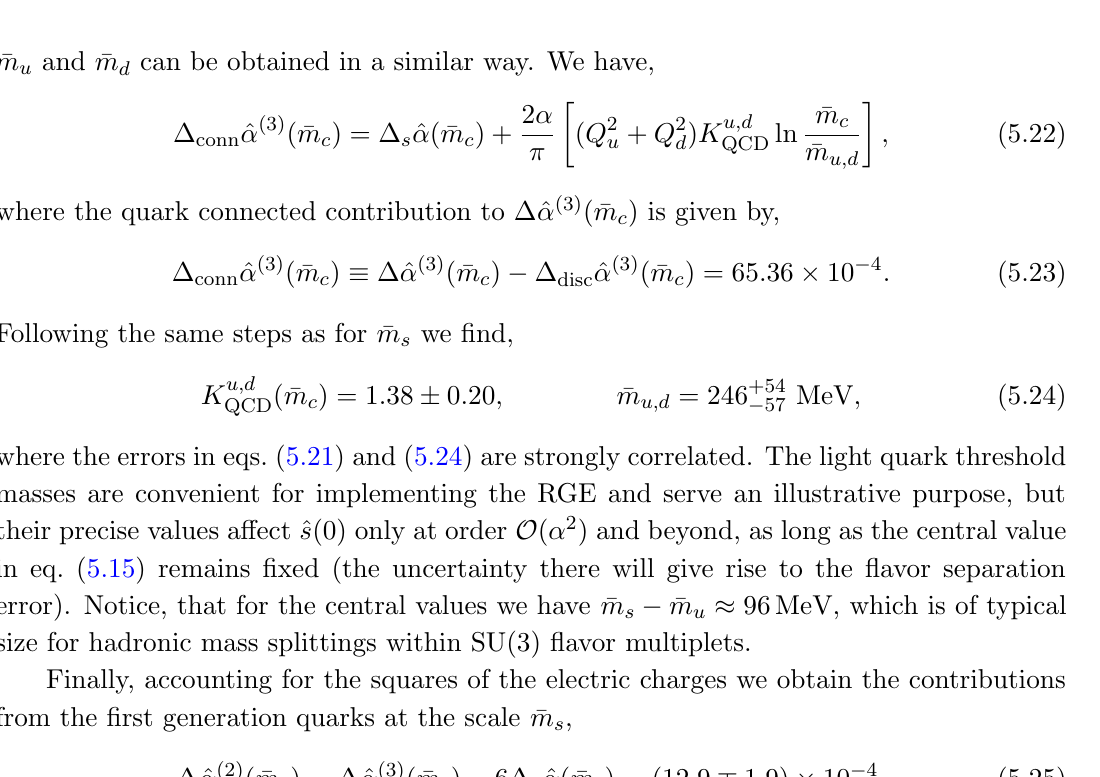
Table 4 . Theoretical uncertainties in the low energy mixing